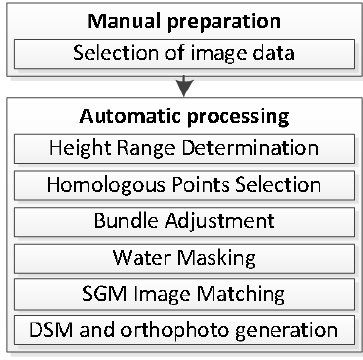
Figure 1: Overview of the processing